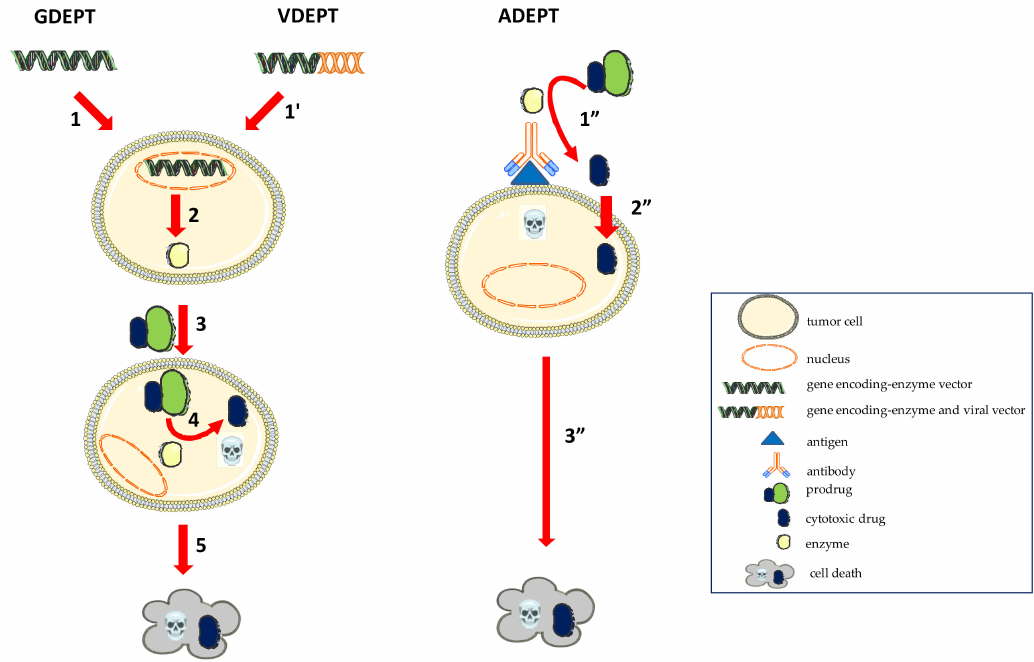
Figure 1. Diagram of ADEPT, VDEPT and GDEPT therapeutic strategies. 1 − The gene encoding an enzyme that is delivered at the target site; 2 − The triggering of the intracellular expression of the enzyme; 3 − Systemic administration of a prodrug; 4 − The activation of an inactive prodrug into an active cytotoxic agent; 5 − The death of the transduced tumor cells; 1’ − Viral vectors providing the gene encoding an enzyme; 1” − The enzyme that is vectorized or catalyzed directly by antibodies, towards antigens expressed on tumor cells, activating the prodrug; 2” − The cytotoxic effect of the active drug that entered into the cells; 3” − The death of tumor